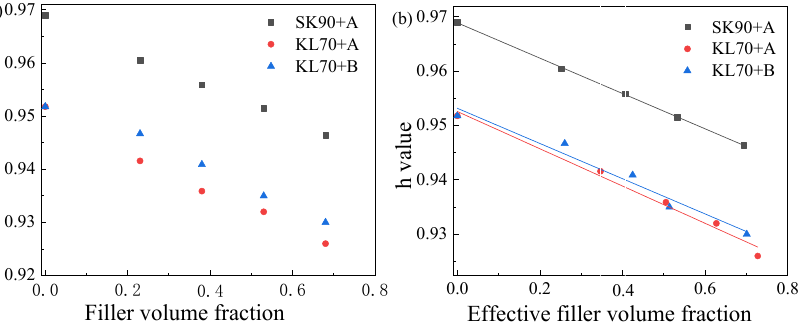
Figure 10. Relationship between h of binders and the corresponding mastics ( a , b ). ( b ) is more observed compare with ( a ). Table 4. Fitting result of the relation between h and effective filler volume fraction.